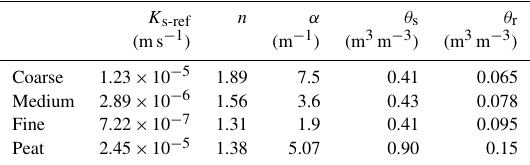
Table 1. Van Genuchten parameters used for different soil texture classes for non-peat soils (coarse, medium, fine) and for peat. θ s is the saturated water content (m 3 m − 3 ) ; θ r is the residual water content (m 3 m − 3 ) ; K s-ref is the reference saturated hydraulic con- ductivity (ms − 1 ) ; α is the inverse of the air entry suction (m − 1 ) ; n is a dimensionless parameter. In Eqs. (1) and (2), m = 1 − 1 /n